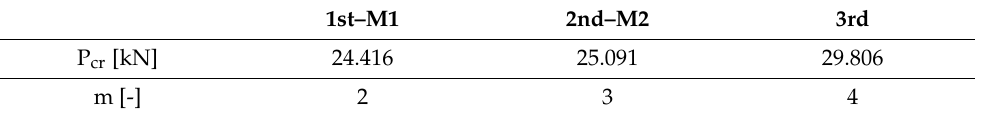
Table 4. Buckling loads (P cr ) and longitudinal half-wave number (m) of considered